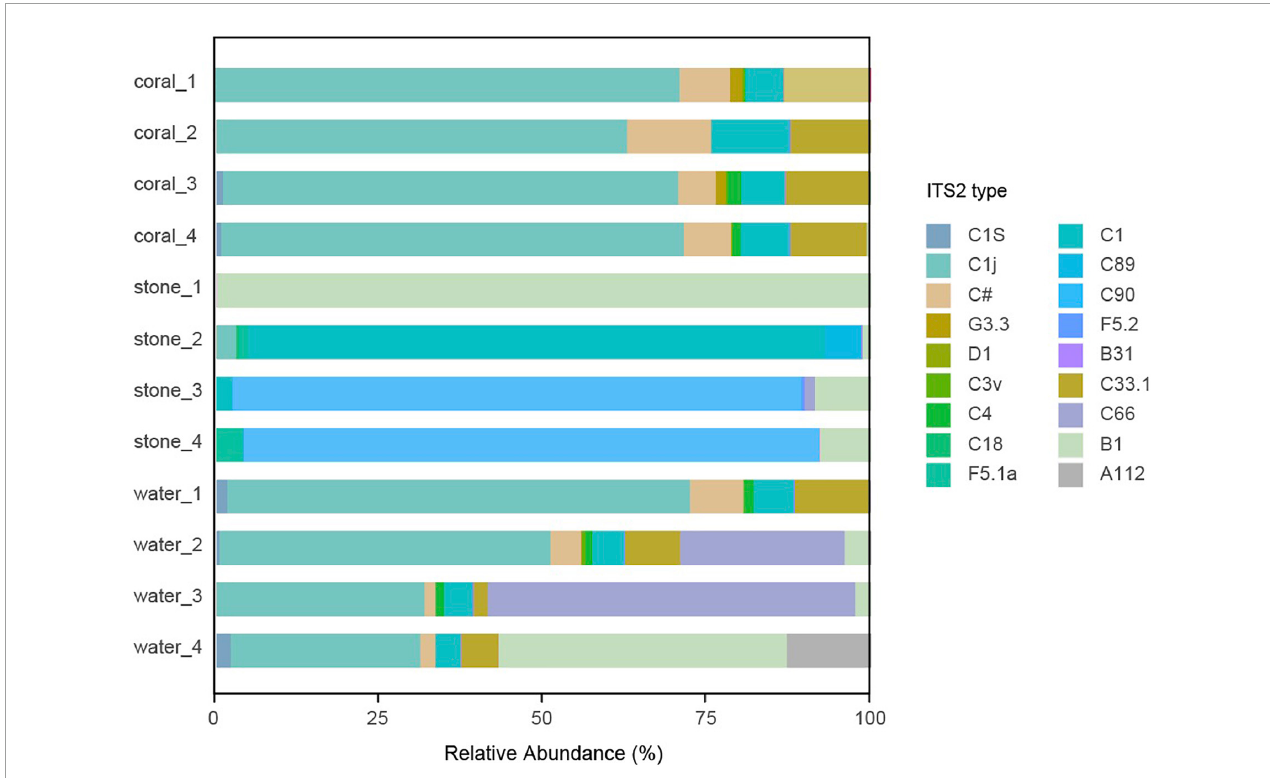
FIGURE9 Community component of algal symbionts in the coral culture system. The total genomic DNA from each group performed high-throughput sequencing using the primer pair of ITS-DINO and ITS2Rev2. The taxonomy of each OTU representative sequence was analyzed according to the algal symbionts’ genomic resource database and classified by ITS2